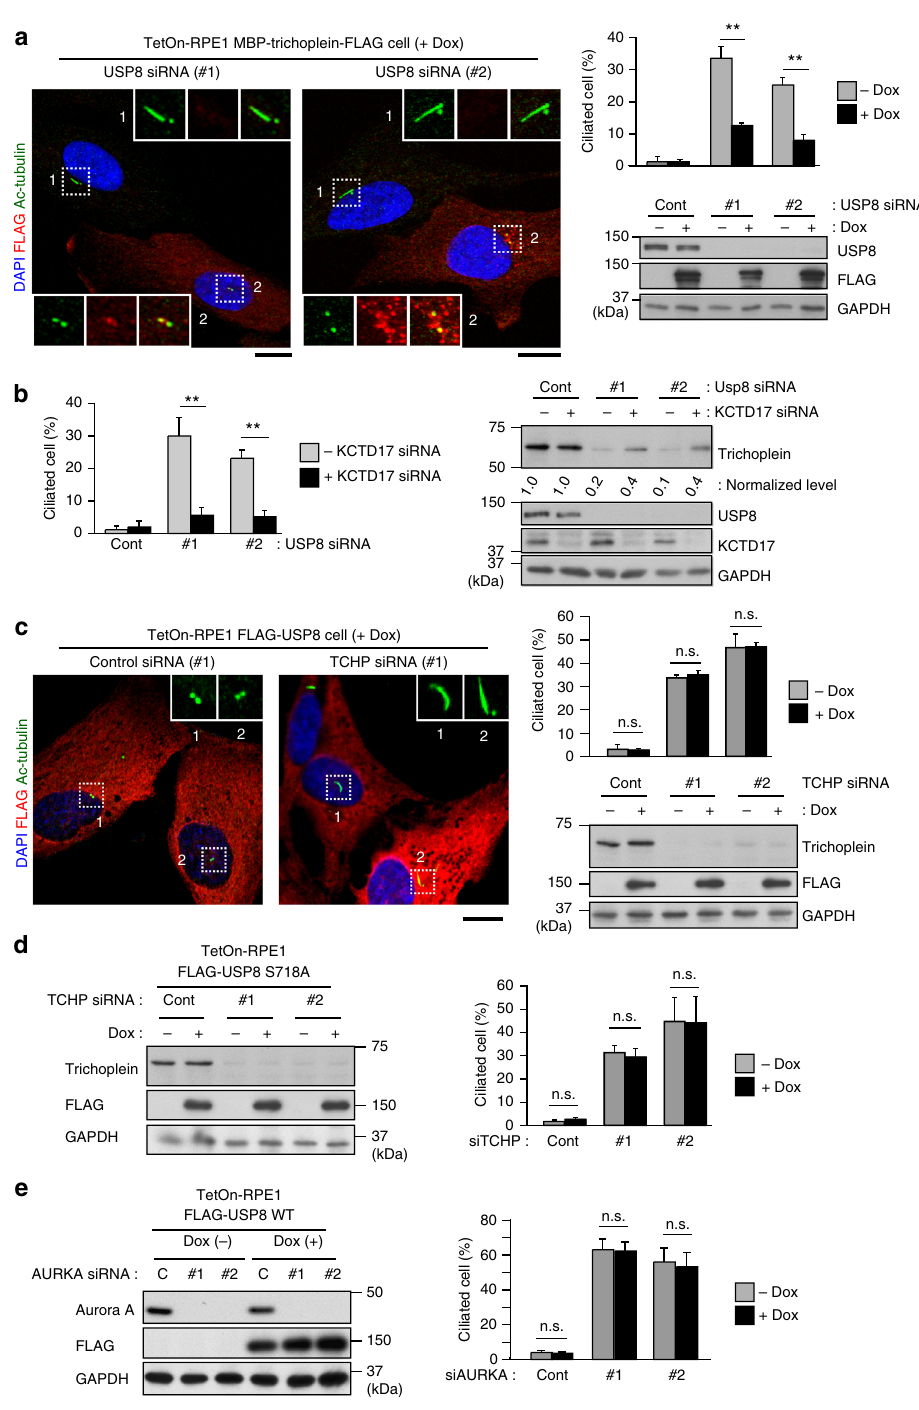
Fig. 4 USP8 suppresses ciliogenesis by counteracting trichoplein degradation. a TetOn-RPE1 MBP-trichoplein-FLAG cells transfected with control or USP8 siRNA (#1 or #2) were cultured for 48 h in the presence or absence of doxycycline (Dox, 30 ng ml − 1 ). b Sixteen hours after transfection with or without KCTD17 siRNA, RPE1 cells were further transfected with control or USP8 siRNA (#1 or #2), and then cultured for 32 h. c – e TetOn-RPE1 FLAG-USP8 WT ( c , e ) or S718A ( d ) cells were transfected with trichoplein ( c , d ; siTCHP, #1 or #2) or Aurora A siRNA ( e ; siAURKA). Six hours after transfection, these cells were treated with 100 ng ml − 1 of Dox. Representative confocal images of acetylated-tubulin (green), FLAG (red) and DAPI (blue), percentages of ciliated cells, and immunoblotting analysis are shown. Normalized intensities of trichoplein/GAPDH are shown as mean from three independent biological replicates in b . Graphs represent mean ± SD from three independent biological replicates ( n > 200 each). ** p < 0.01, *0.01 < p < 0.05, n.s. not signi fi cant, two-tailed unpaired student ’ s t -tests. Scale bars, 10 μ